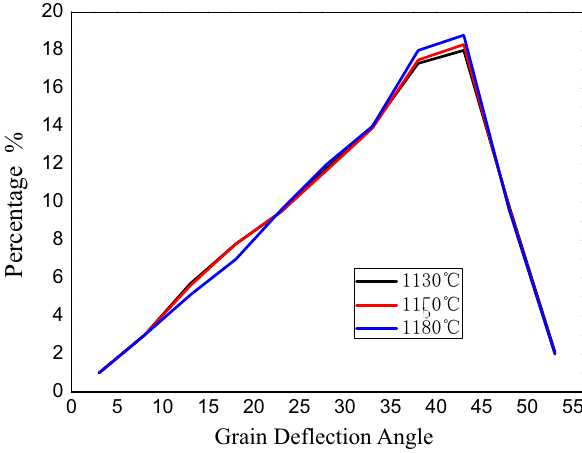
Figure 4: Distribution of grain de fl ection angle at di ff erent casting